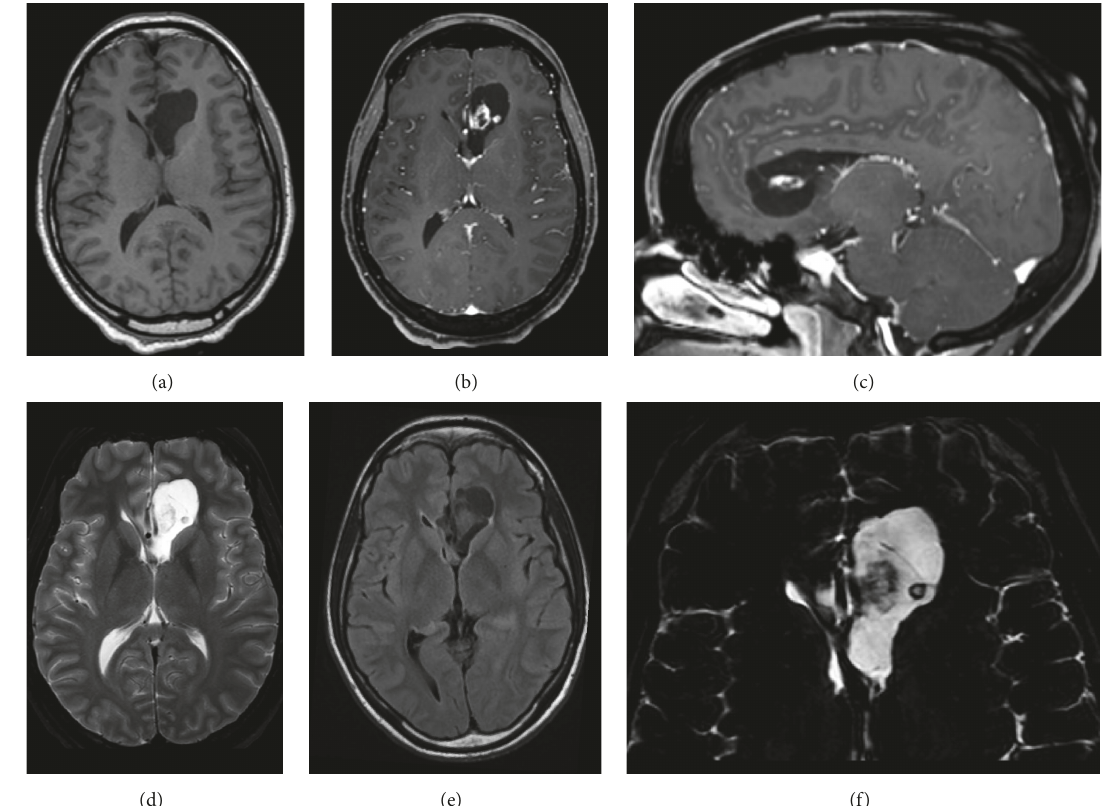
Figure1:Precontrastaxial(a),postcontrastaxial(b),andpostcontrastleftparasagittal(c)T1-weightedMRimagesofthebraindemonstratean intra-axial left frontal mass with heterogeneous internal nodular and septal enhancement. The largest enhancing component is subjacent to markedly thinned medial left frontal cortex. T2-weighted axial images (d) demonstrate hyperintense cystic formation with near complete suppression on FLAIR sequences (e). No peritumoral T2 hyperintensity is present to suggest vasogenic edema or gliosis. Details from high-resolution, heavily T2-weighted images (f) redemonstrate mixed solid and cystic components and thin internal septation. No elevated perfusion or abnormally restricted diffusion was identified on MR perfusion or diffusion-weighted imaging, respectively (not